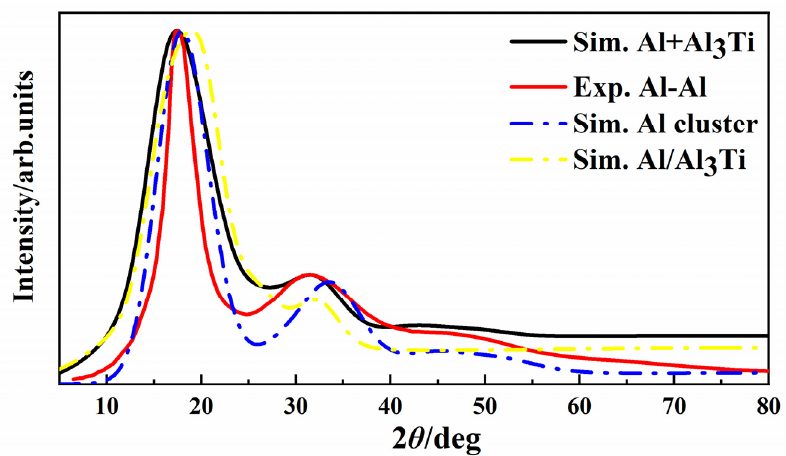
Figure 5. Comparison of the experimental partial Al–Al XRD pattern with simulated one. As has been established the Al–Ti partial structural factor is completely contributed by the Al 3 Ti cluster; however, the Al 3 Ti cluster contributes not only to the Al–Ti, but also to the Al–Al partial structural factors. The Al–Ti partial XRD pattern and the simulated one of Al 3 Ti cluster (shown in Figure 6a) are not comparable; however, it is difficult to divide the XRD pattern of the Al 3 Ti cluster into the Al–Ti and Al–Al parts. Considering that the Al–Al partial structural factor is contributed to by both the Al and Al 3 Ti clusters, it is reasonable to compare the combination of the Al–Al and Al–Ti partial XRD patterns (red line in Figure 6b) with the combination of the simulated XRD results of the pure Al and Al 3 Ti clusters. To determine the composition ratios of Al clusters and Al 3 Ti clusters, the simulated diffraction peaks, formed by different composition ratios (100% Al cluster; 60% Al, 40% Al 3 Ti; 50% Al, 50% Al 3 Ti; 40% Al, 60% Al 3 Ti; 100%Al 3 Ti cluster) were shown in Figure 6b (black line, yellow line, blue line, green line, and pink dashed line, respectively). The composition of 50% Al and 50% Al 3 Ti simulated curve showed an excellent agreement with the experimental curve. In summary, the Wulff cluster model can successfully describe the melt structure of Al–Ti alloys and can explain the contribution of every kind of clusters. The most important point is that the atomic structure of the cluster we got is not a cluster of specific existence in melts. It is the most probable cluster structure of a structure distribution in melts, through the statistical average of time and space, similarly to X-ray diffraction.